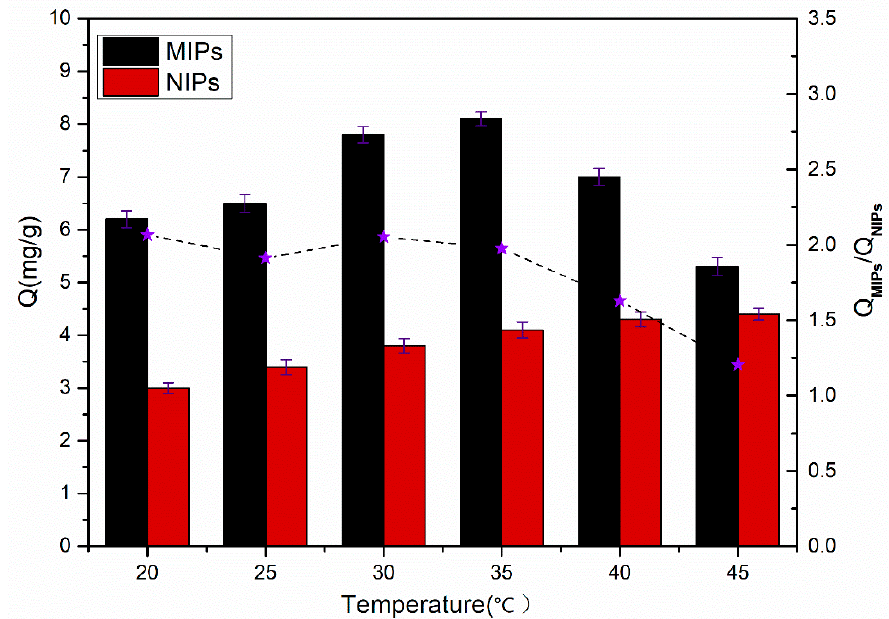
Figure 7. The adsorption capacities of MIPs and NIPs at different temperatures (10 mg of MIPs/NIPs in 5 mL of 0.3 mmol·L − 1 SMZ solution for 5 h). Each Q value takes the average of three measurements, and the error bars represent the standard deviation (SD).